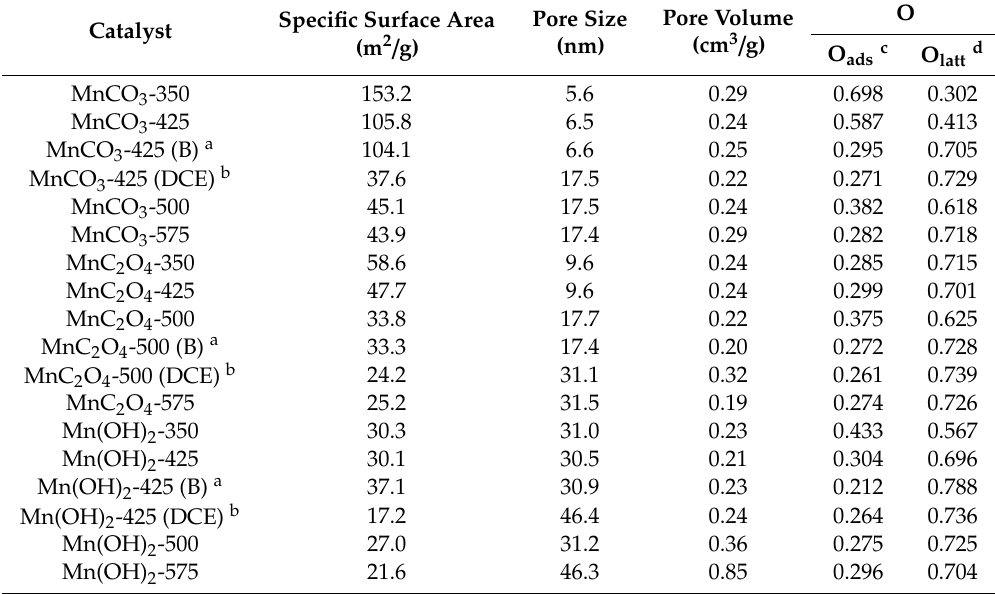
Table 2. Characterization data for the manganese oxide